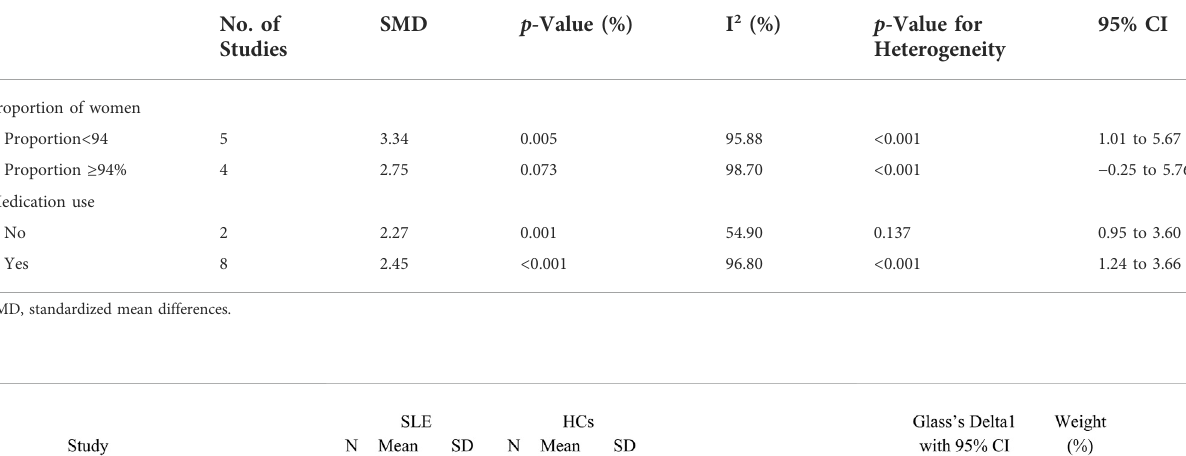
TABLE 2 Subgroup analysis in IL-10 according to the proportion of female SLE patients in total patients and the use of medication.